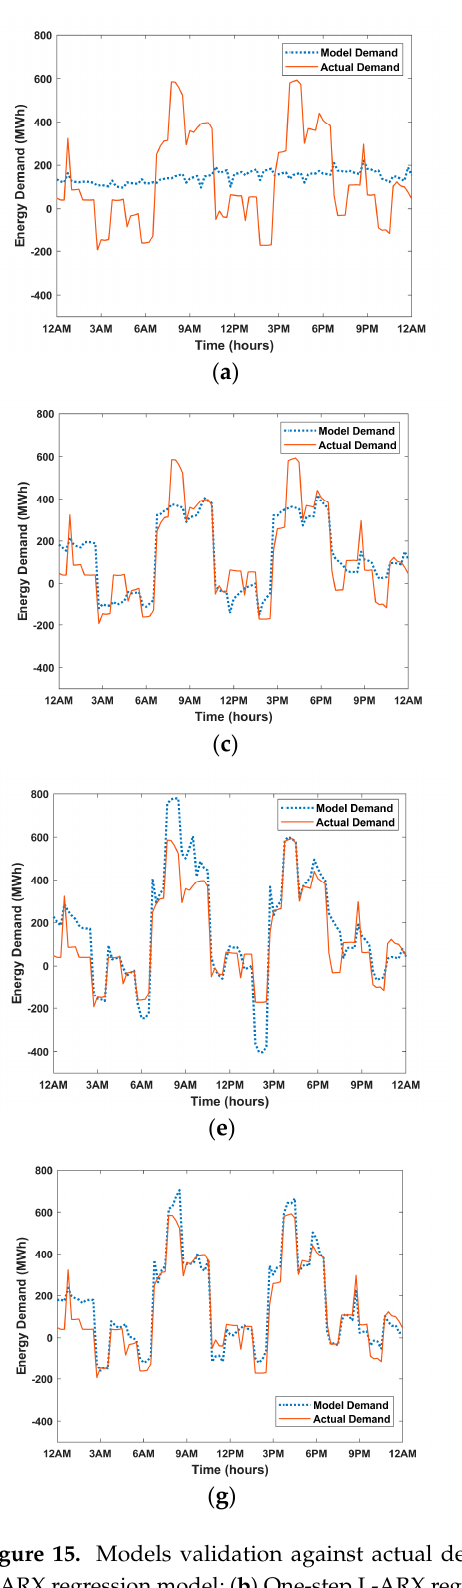
Figure 16. Frequency profile that corresponds to the energy demand profile presented in Figure 15. To evaluate the models numerically, Table 2 shows the values of the coefficient of determination (R 2 ), root mean squared error (RMSE), and normalized root mean squared error (NRMSE) for each model with the training and validation dataset and the testing datasets. The values shown for testing are the average values obtained from the ten testing datasets. Equations (14)–(16) were used to calculate R 2 , RMSE, and NRMSE, respectively. 𝑅 (cid:2870) (cid:3404) 1 (cid:3398) ∑ (cid:4666)𝑦 (cid:3028)(cid:3030)(cid:3047)(cid:3048)(cid:3028)(cid:3039),(cid:3036) (cid:3398) 𝑦 (cid:3040)(cid:3042)(cid:3031)(cid:3032)(cid:3039),(cid:3036) (cid:4667) (cid:2870) (cid:3041) (cid:3036)(cid:2880)(cid:2869) ∑ (cid:4666)𝑦 (cid:3028)(cid:3030)(cid:3047)(cid:3048)(cid:3028)(cid:3039),(cid:3036) (cid:3398) 𝑦(cid:3364)(cid:4667) (cid:2870)(cid:3041) (cid:3036)(cid:2880)(cid:2869)